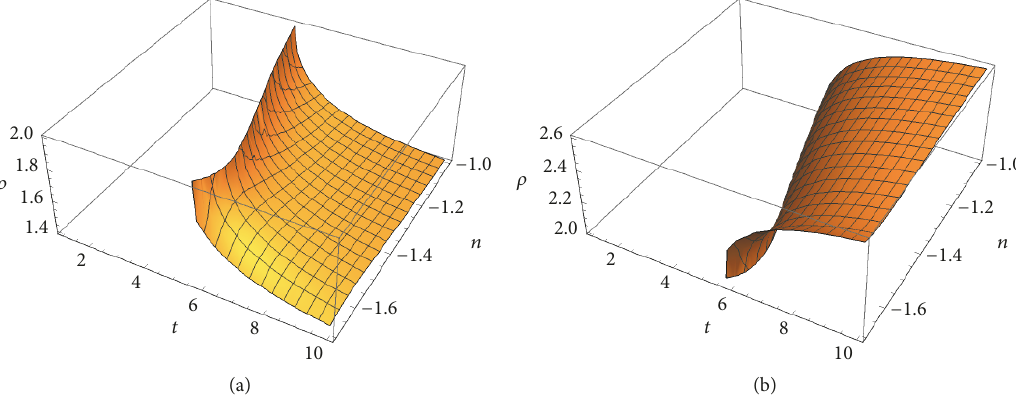
Figure 4: Behaviour of 𝜌 for ultrarelativistic